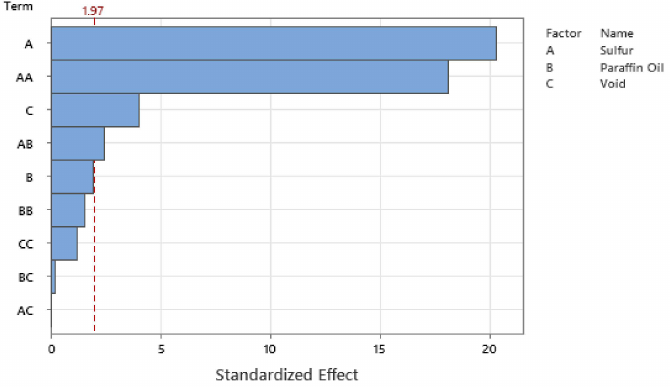
Figure 30. The Pareto Chart of Standardized Effects for tan δ .